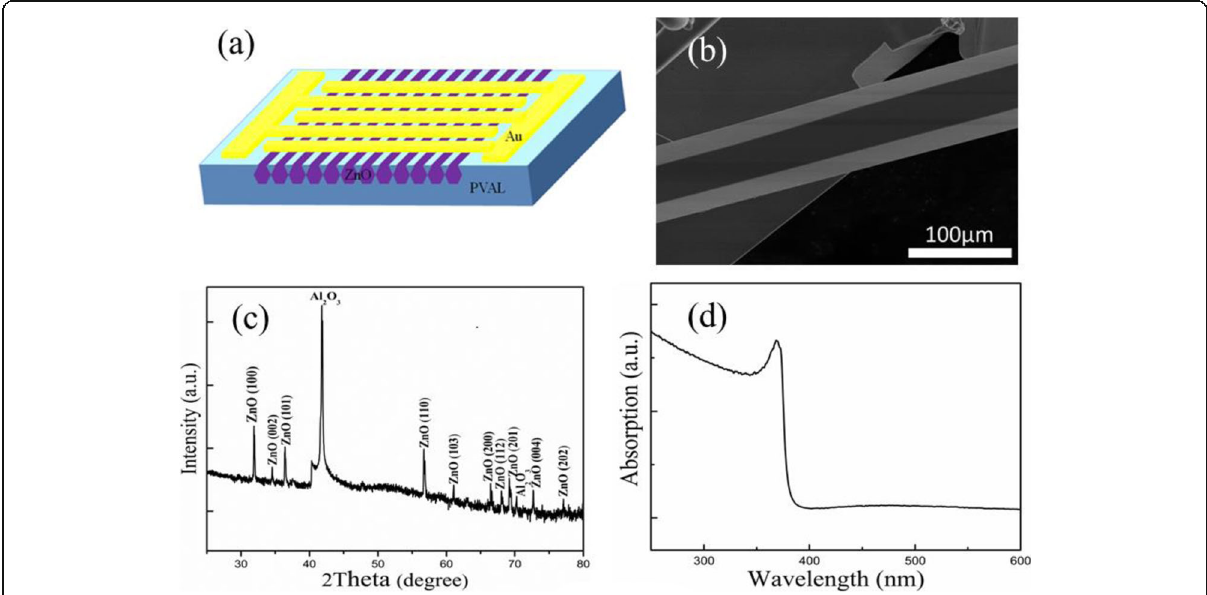
Fig. 1 a The schematic of ZnO MW array UV PD device. b SEM micrograph of the synthesized ZnO MWs. c XRD pattern of the ZnO MW sample on the sapphire substrate. d Absorption spectrum of the ZnO